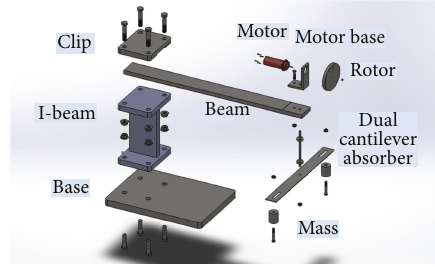
Figure 1: Exploded 3D view of the experimental setup